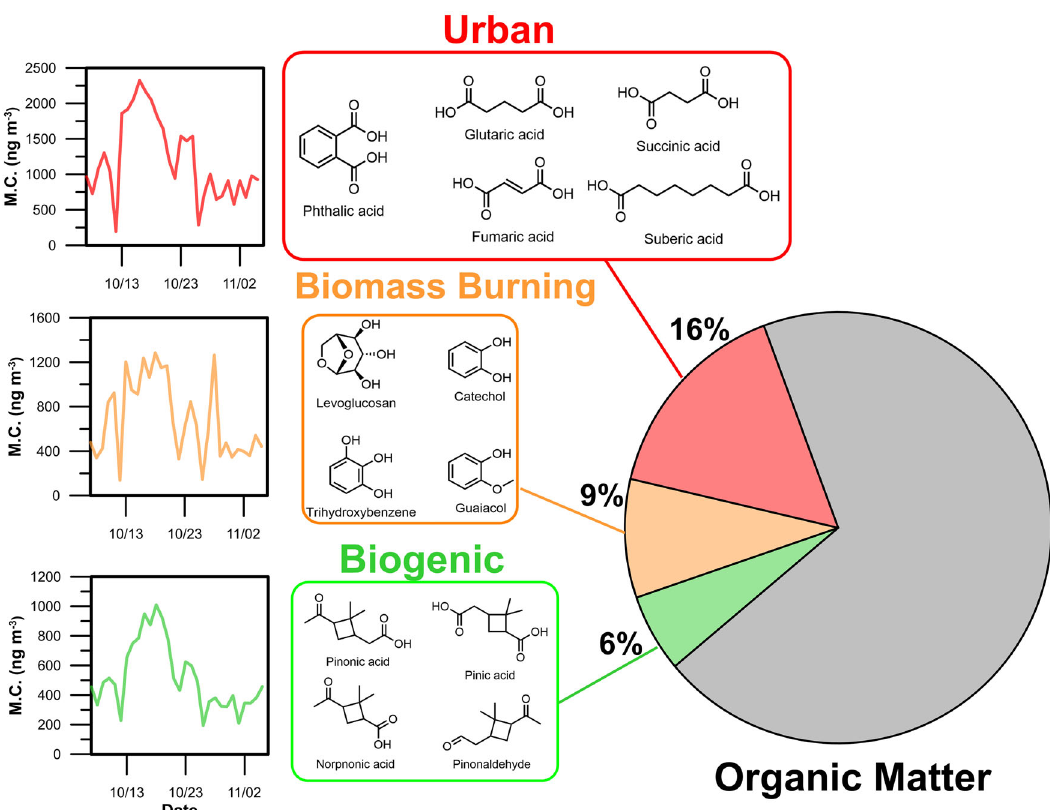
Fig. 4 Time series pro fi le and contribution to OM of the major organic markers, clustered according to their primary